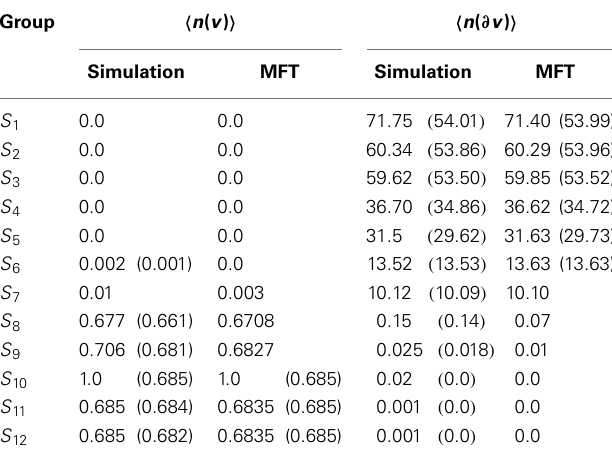
FIGURE 5 | 12-group architecture with self . (A) We permanently occupy one of the hole groups, group 10 (cyan), thus mimicking the permanent presence of self.This state is not favorable since the self couples to singletons and periphery, which have a high occupation. (B) Letting the thus prepared system evolve, it soon reaches a new steady state, still a 12-group architecture, but organized such that the self now belongs to the singletons and thus couples only to the almost empty stable holes.The self-recognizing idiotypes are controlled by the network, thus providing